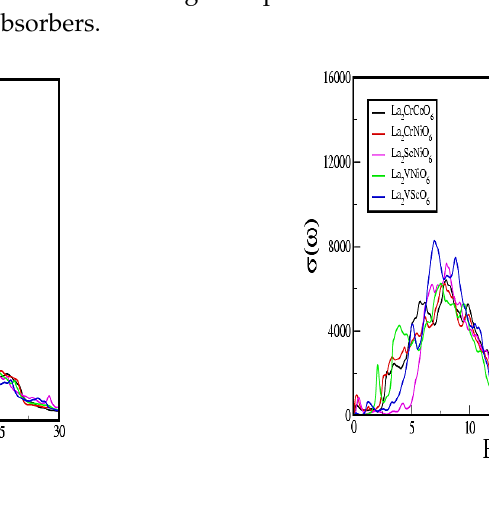
Figure 10. ( a ) Optical conductivity of DPC La 2 BB ′ O 6 using GGA and ( b ) GGA+U.